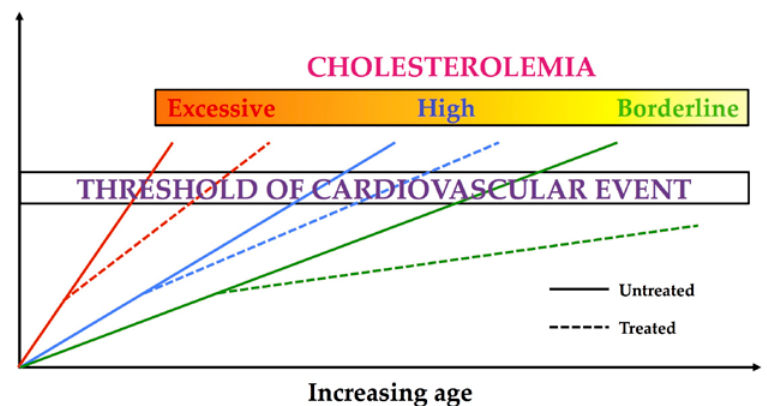
Figure 1. Treatment effect linked to cholesterol levels on the potential age of clinical cardiovascular event appearance. Treated means a multifactor intervention, i.e., dietary and lifestyle modifications plus the consumption of functional foods plus the use of drugs.